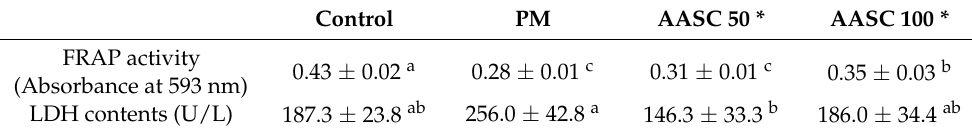
Table 4. Effect of AASC on biomarkers related to oxidative stress in serum of mice exposed to PM 7.5 .